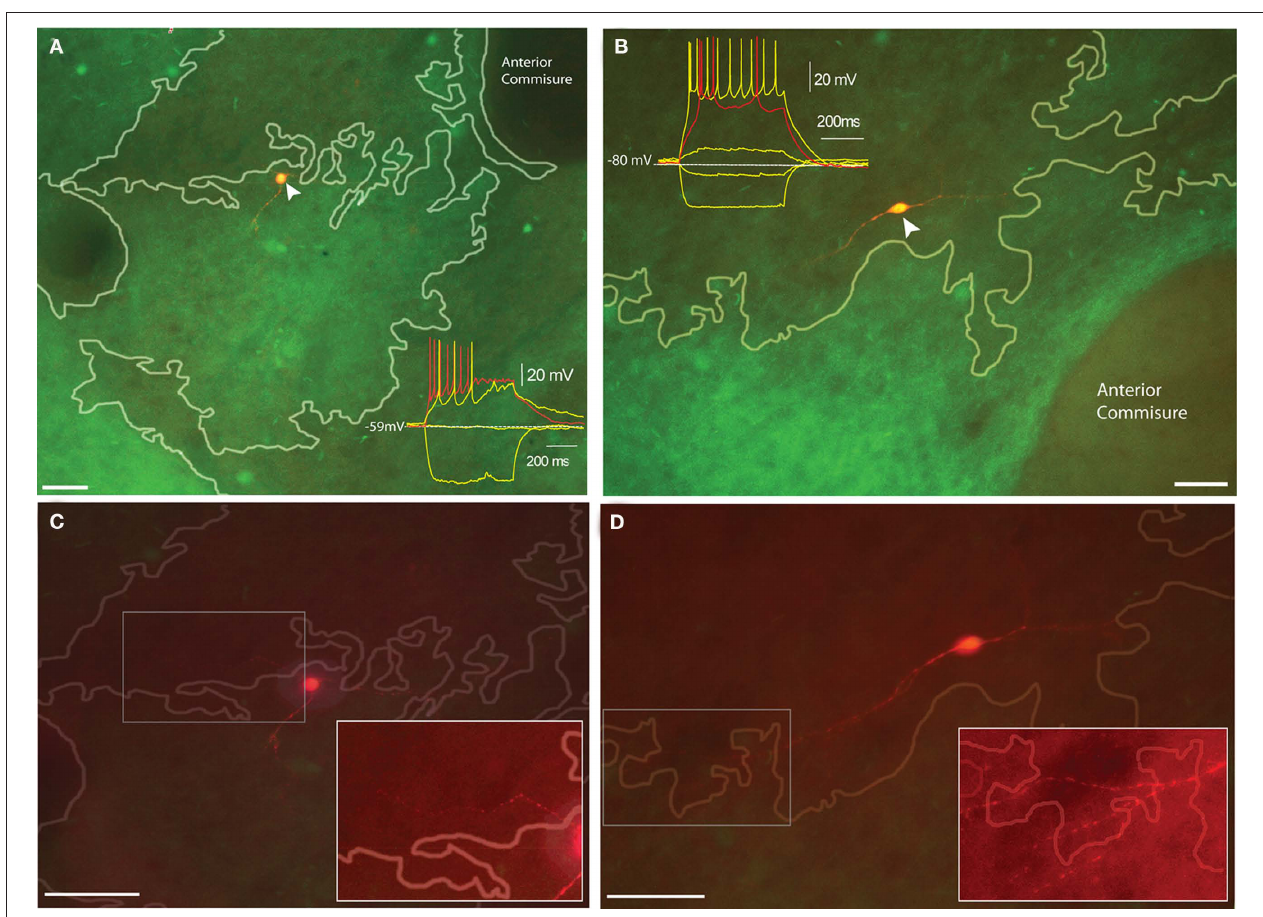
TH-eGFP neuron in (A) . The boxed region corresponds to the contrast-enhanced inset showing the proximal neurite crossing a compartmental boundary. (D) The maximal projection of the image stack obtained at 5 μm intervals of the Type IV TH-eGFP neuron in (B) . The boxed region corresponds to the contrast-enhanced inset showing the distal neurites crossing a compartmental boundary. Scale bars, 50 μm. Note different scale markers in [ (A,C) , (B,D) ].